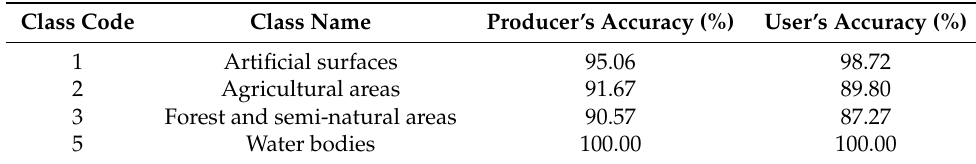
Table 8. Accuracy assessment results of Level 1